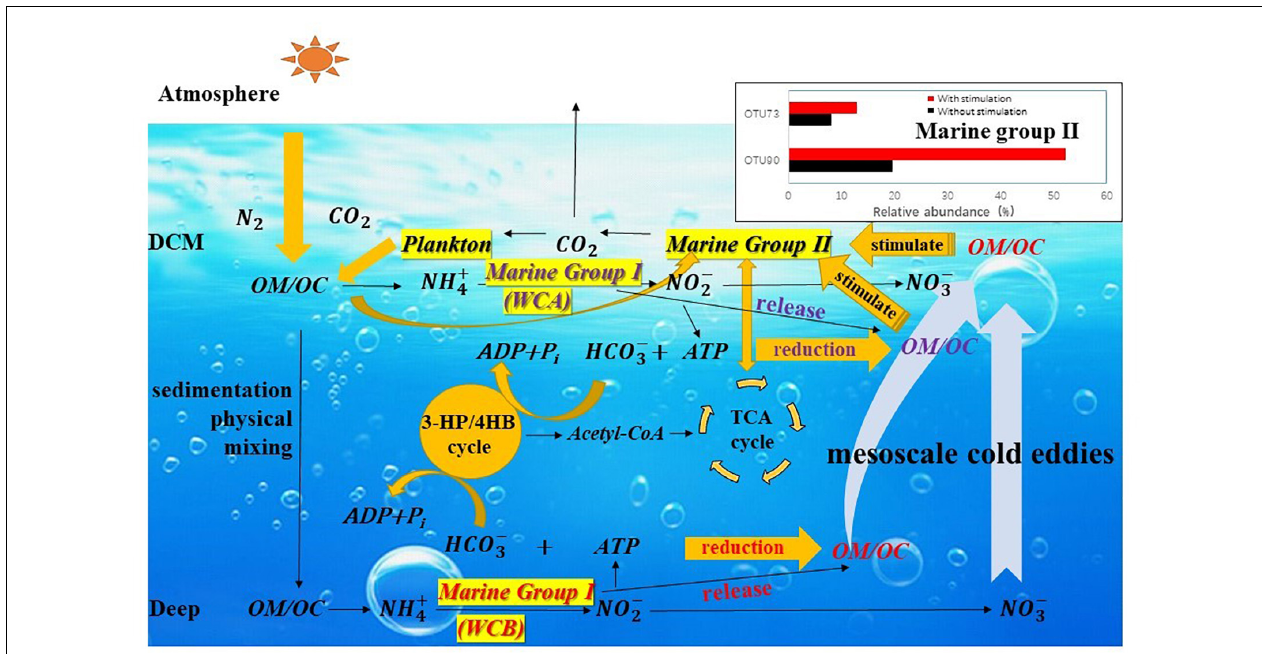
FIGURE 7 | The possible mechanism by which the growth of Marine Group II Euryarchaeota is stimulated by carbon flow affected by mesoscale eddies. Particulate organic matter (POM) produced in the upper ocean enters the ocean interior by sedimentation and physical mixing and releases NH 4 + under the action of heterotrophic microorganisms. MGI Thaumarchaeota couples the oxidation of ammonia with carbon fixation in HCO 3 − through the 3HP/4HB pathway, and the intermediate acetyl-CoA can act as a precursor of the TCA cycle and participate in the metabolism of MGII. Much organic matter produced by ammonia-oxidizing archaea stored in mesopelagic water is brought into the DCM layer by the mesoscale process. This new organic carbon provides a carbon source for heterotrophic MGII members and rapidly stimulates the growth of specific MGII taxa. The CO 2 produced during degradation is released into the atmosphere by sea–air exchange or supplied to plankton of the DCM